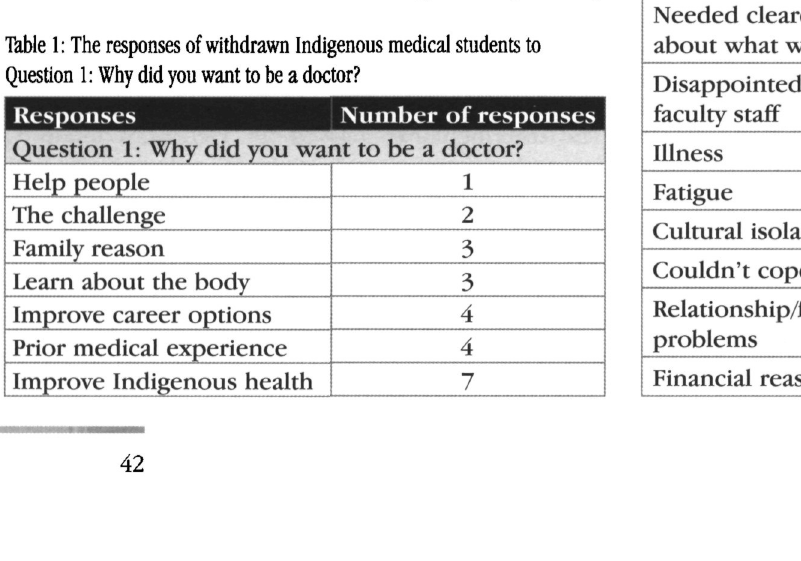
Table 1: The responses of withdrawn Indigenous medical students to Question 1: Why did you want to be a doctor?